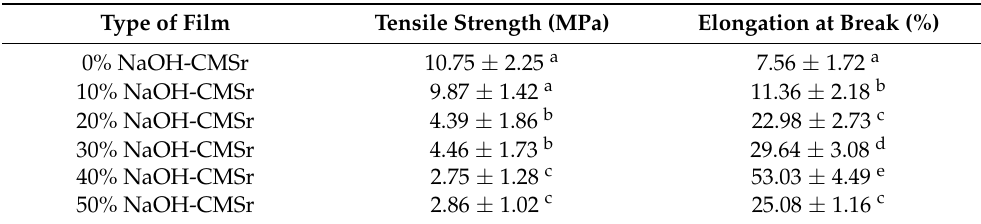
Table 2. Tensile strength (MPa) and elongation at break (%) of CMSr films synthesized with different NaOH